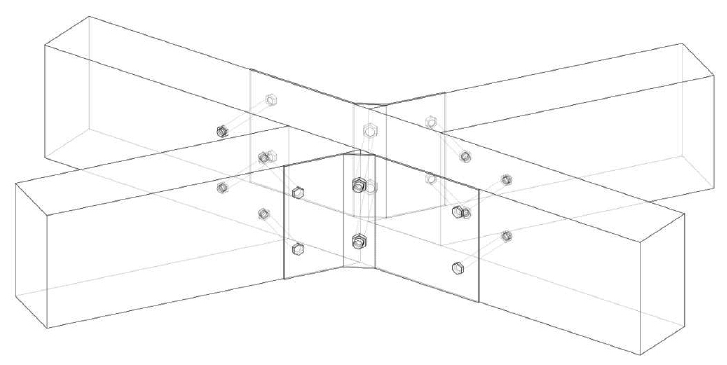
Figure 6. A modification of Zollinger’s joint, with steel plates and additional bolts. The axes of the lamellae intersect at the node.